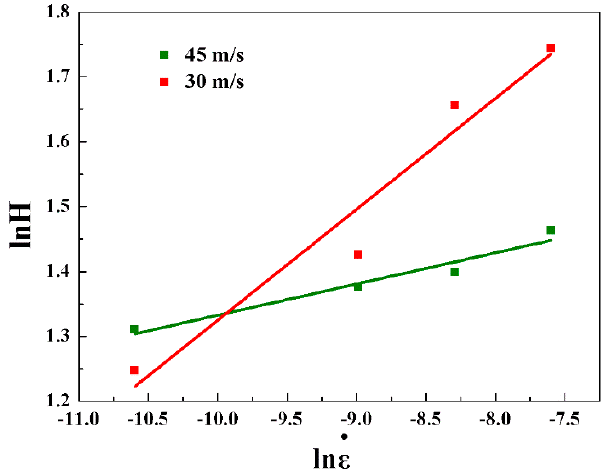
Figure 3. Nanoindentation results of the hardness as function of the strain rate for (TiZr) 0.5 (Ni 0.6 Cr 0.1 V 0.1 ) 2.1 amorphous ribbons with spinning speeds of 30 m/s and 45 m/s.